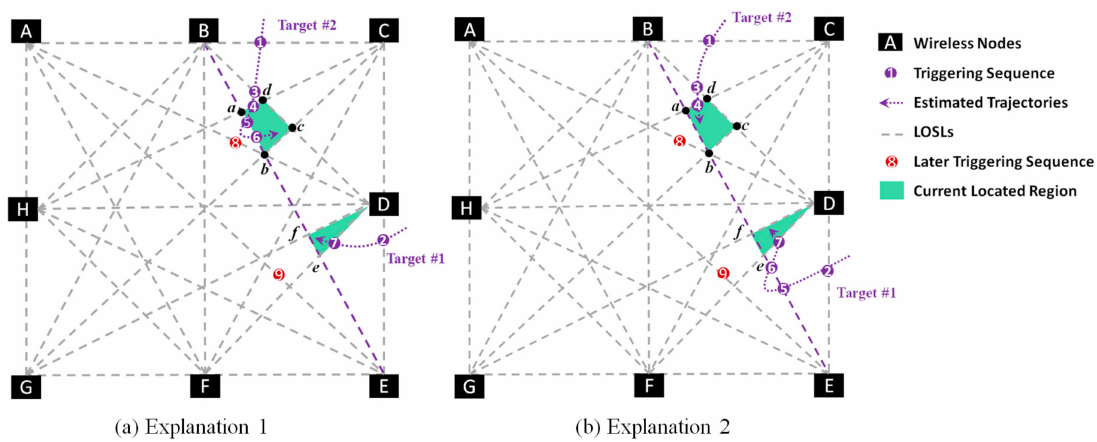
Figure 5. Illustration for eliminating the fake Explanation 1 and 2 using the later triggering sequence